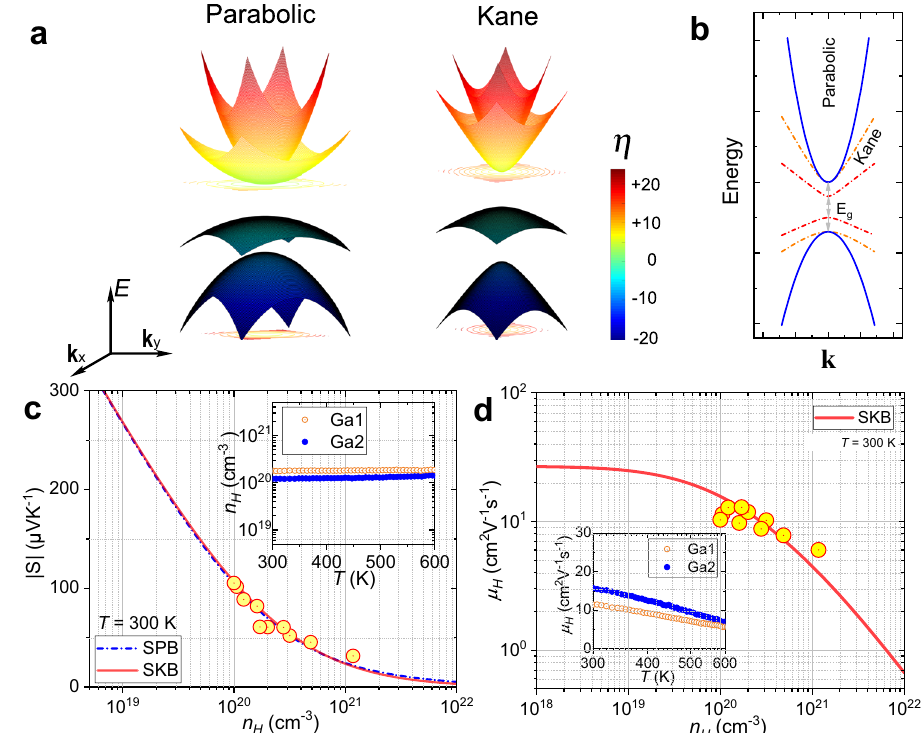
Fig. 3 Electronic transport properties. a 3D illustration of Parabolic and Kane bands with asymmetric conduction and valence bands. The features of conduction band nesti fi cation and relative fl at valence band are presented. b E ~ k dispersions of parabolic (solid blue line) and Kane bands with different band gaps, E g (orange and red dot-dash lines). c Hall electron concentration, n H dependence of the magnitude of Seebeck coef fi cient (Pisarenko plot). The inset shows the temperature dependence of n H of two compositions, Ga1 (red circle) and Ga2 (blue circle). d Hall mobility, μ H as a function of n H . The red solid line is calculated based on the single Kane band (SKB) model. The inset shows the temperature dependence of μ H of Ga1 and